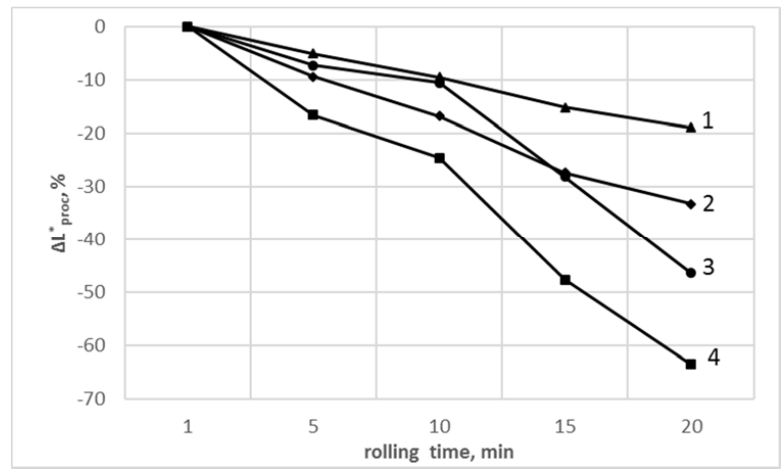
Figure 5. The relative change of Δ L* proc values of PVC and PVC/SiO 2 processed in various rolling times vs. PVC and PVC/SiO 2 taken after 1 min as a function of processing time: (1) PVC R /SiO 2; (2) PVC R ; (3) PVC C /SiO 2 ; (4) PVC C .